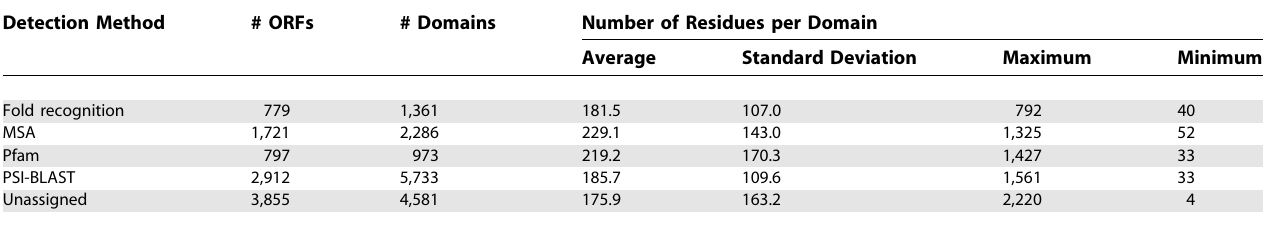
Table 1. Summary of Domain Assignments for the Yeast Genome Made Using the Ginzu Method Detection